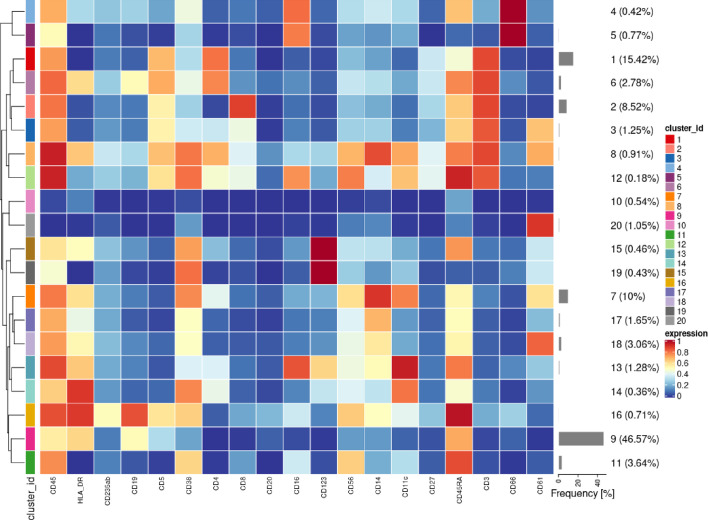
Heatmap of the median lineage protein expression across clusters with the associated cluster percentages measured for all cells and all samples in the first dataset of samples from 3 patients with CLL and 9 HC.